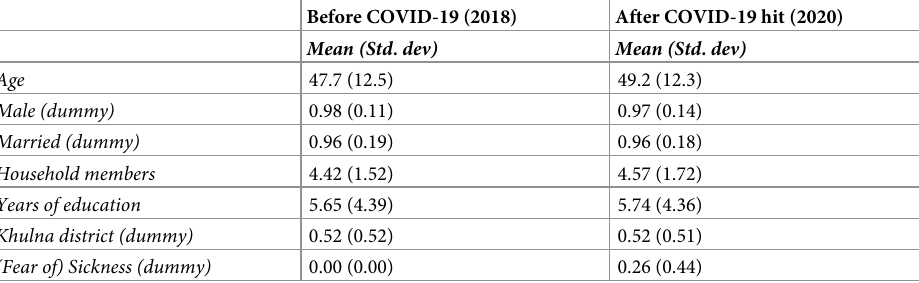
Table 1. Descriptive statistics of selected explanatory